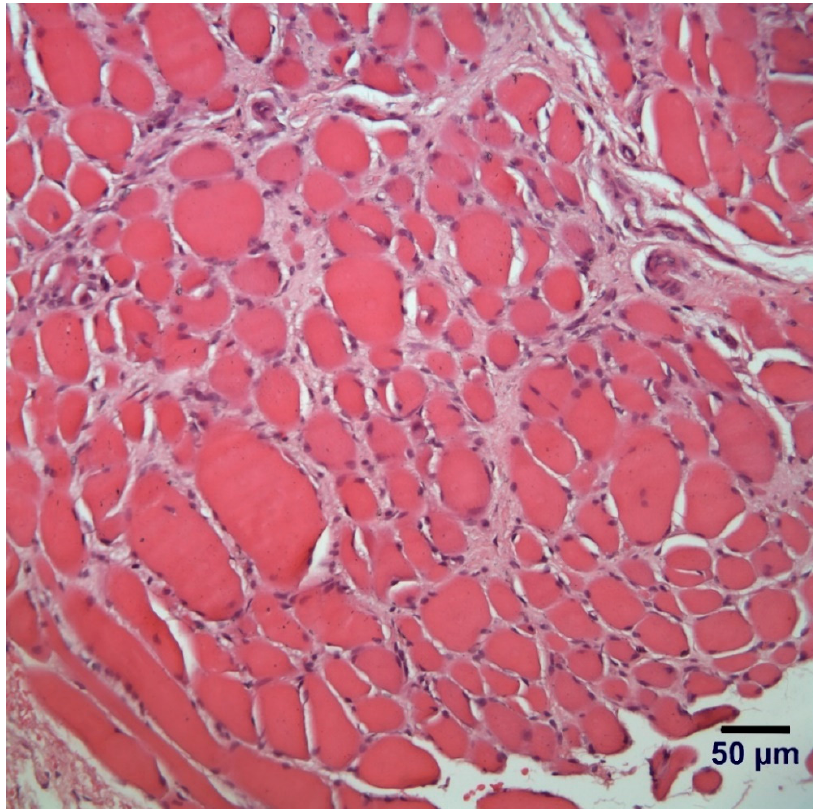
Figure 2. Hematoxylin and eosin (H&E) stained paraffin embedded section from gluteus muscle showing a marked variability in myofiber size, endomysial fibrosis and scattered myofiber showing internal nuclei. A form of congenital muscular dystrophy was suspected.